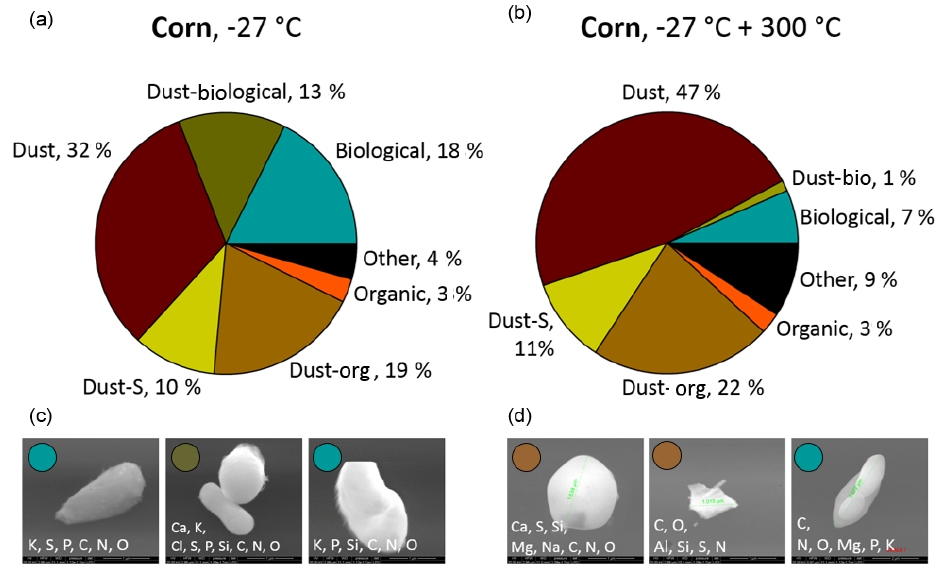
Figure 4. SEM-EDX data collected during a corn harvest. Panels (a) and (b) show relative amounts of each particle type as sampled using EDX, while (c) and (d) show example images of particles analyzed with SEM. The colored circle in the top left corner of the images indicates which chemical class the particles were classified as. Elemental composition is given in white on each of the example images. The data were collected at a CFDC operating temperature of − 27 ◦ C with the left-hand side (a, c) showing data without heat and the right-hand side (b, d) showing data for particles that had passed through a heating tube at 300 ◦ C upstream of the CFDC. Overall, 67 and 72 particles were analyzed to make the pie charts in (a) and (b) ,